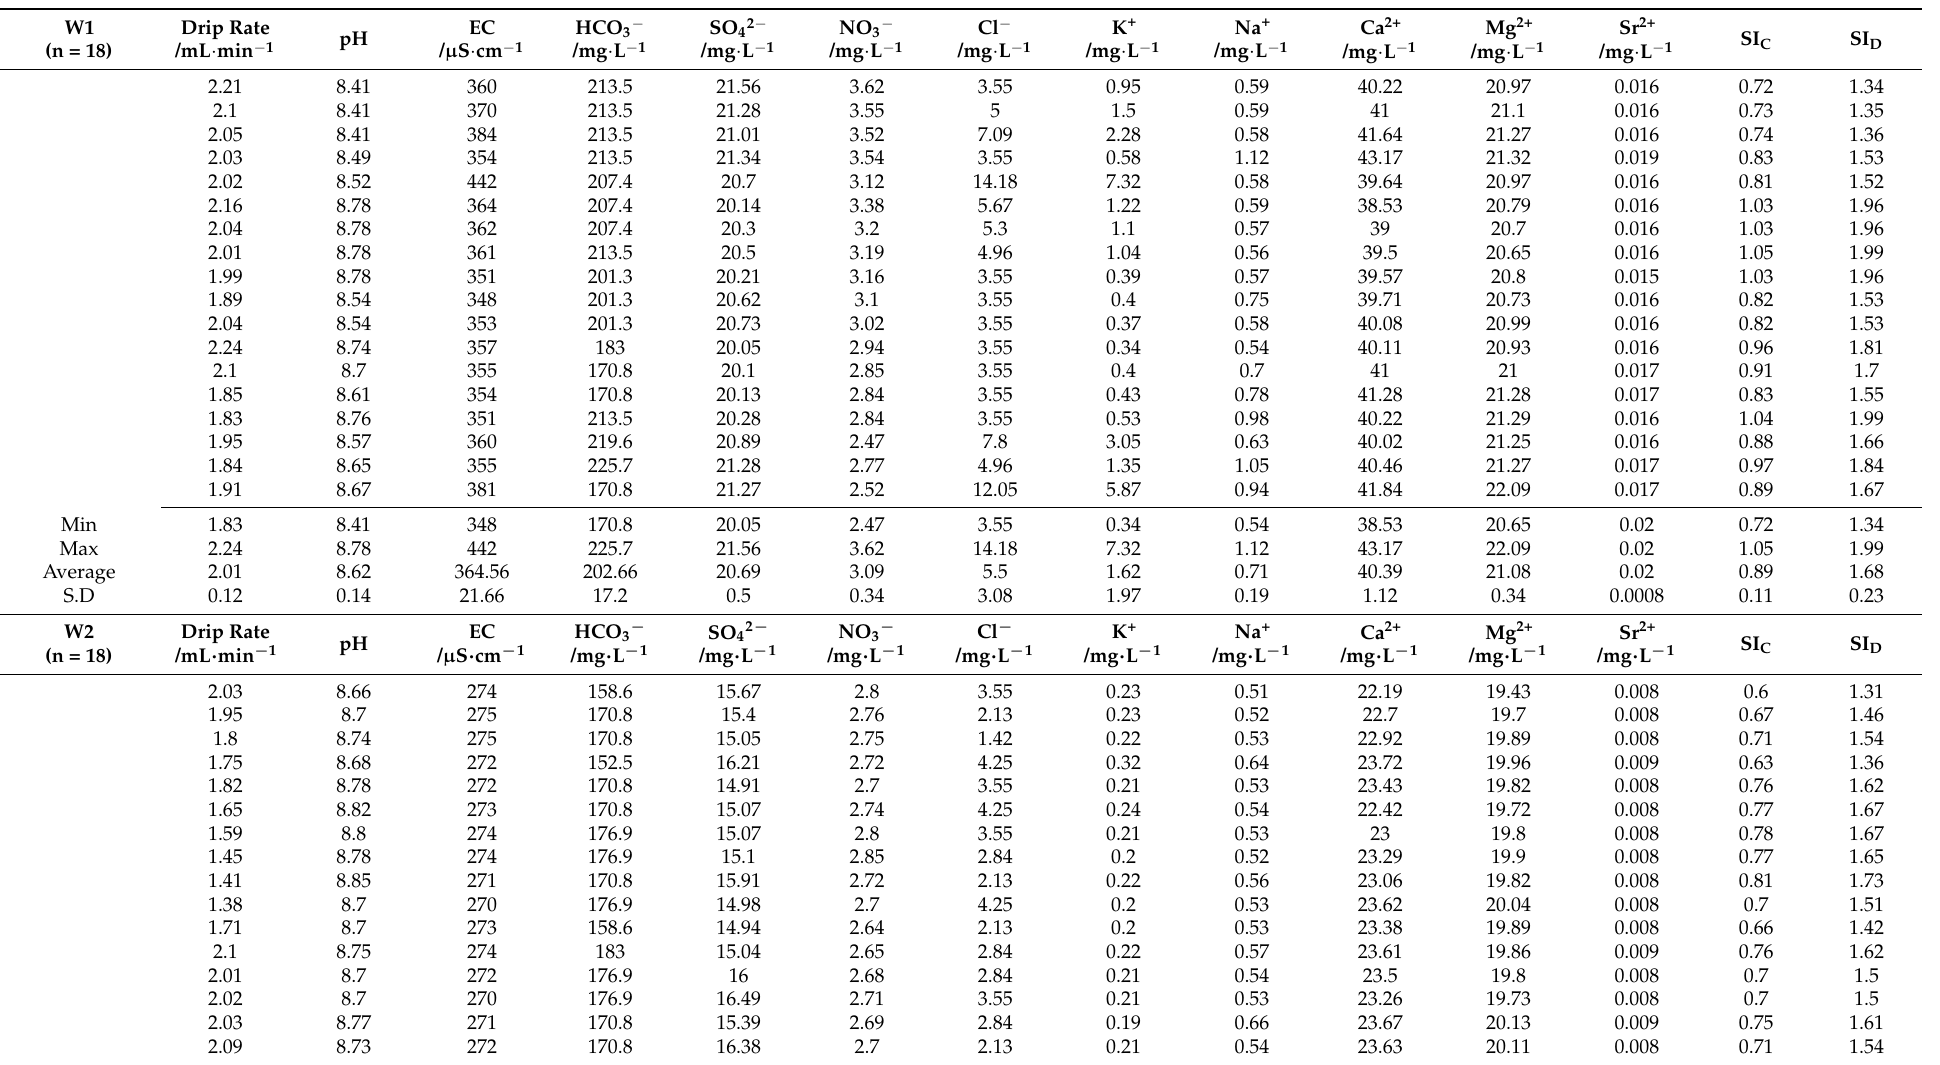
Table 1. Temporal-ordered parameters and descriptive statistics of the drip water hydrogeochemical composition in the Shijiangjun Cave. W1 (n =